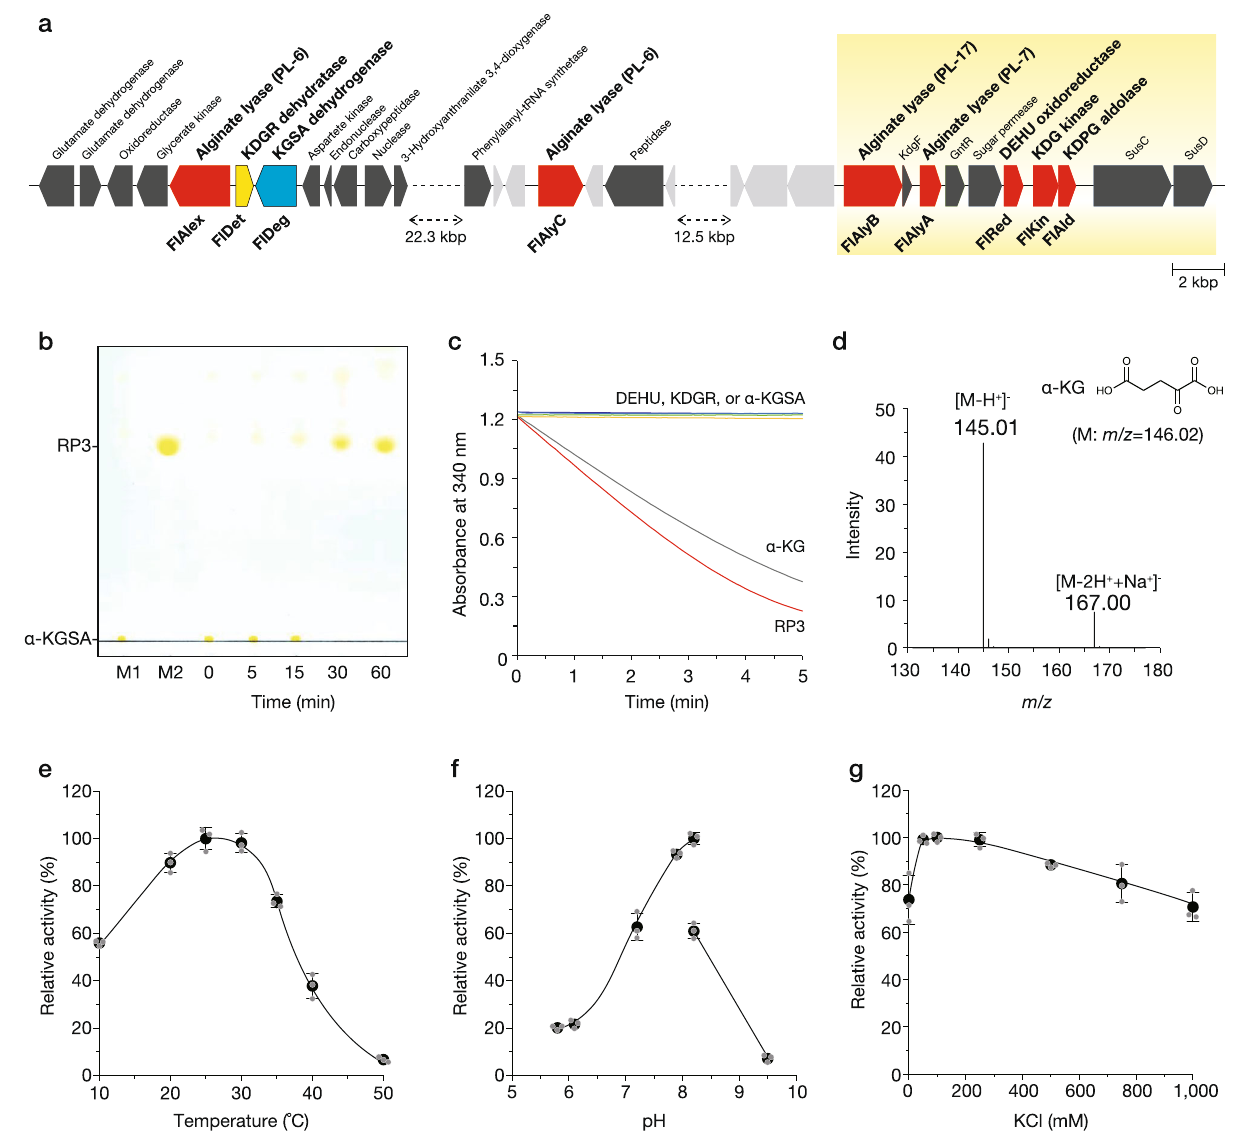
Fig. 3 Oxidation of α -KGSA by FlDeg. a The location of several genes encoding proteins for alginate metabolism in the genome of strain UMI-01. Genes shown as red pentagons encode characterized enzymes 27,33,47 . The yellow pentagon is the FlDet gene identi fi ed in this study. The blue pentagon indicated the gene for a α -KGSA dehydrogenase candidate, termed FlDeg. Dark and light gray pentagons represent genes encoding proteins, the functions of which were predicted and unpredicted from the deduced amino acid sequences, respectively. A yellow-shaded box shows the alginolytic cluster proposed in the previous studies 33, 44 . b TLC analysis of 2,4-dinitrophenylhydrazine derivatives. M1 and M2 represent the derivatives of α -KGSA (prepared from KDGR using FlDet and puri fi ed) and α -KG (commercially purchased), respectively. Reaction was conducted in a mixture containing 10 mM potassium phosphate (pH 7.4), 100 mM KCl, 1 mM MgCl 2 , 1 mM DTT, 2.5 mM NAD + , and 20 µ g mL − 1 recFlDeg at 25 °C. The enzymatic reaction was stopped by adding one- sixth volume of 6.3 mM DNP in 3 M HCl at the indicated time and the derivatization was performed as described in “ Methods ” . c Change in absorbance at 340 nm corresponding to the consumption of NADH by bovine L-glutamic dehydrogenase (GDH). Reaction was conducted in 20 mM potassium phosphate (pH 7.4), 100 mM KCl, 20 mM NH 4 Cl, 0.2 mM NADH, and 1 U mL − 1 GDH with 0.5 mM puri fi ed RP3 (red), standard α -KG (gray), DEHU (blue), KDGR (green), or α -KGSA (yellow) at 25 °C. d The negative-ion ESI mass spectrum of puri fi ed RP3. A possible structure of RP3 predicted from the determined mass is shown in the inset. e – g The effects of temperature ( e ), pH ( f ), and KCl ( g ) on recFlDeg activities. In ( e ), reaction was conducted in 10 mM potassium phosphate (pH 7.4), 100 mM KCl, 1 mM MgCl 2 , 1 mM DTT, 1 mM KDGR, and 3 µ g mL − 1 recFlDeg at the indicated temperatures for 10 min. In ( f ), the assay condition was same as that in e except that the reaction was conducted with 10 mM potassium acetate (pH 5.8 – 8.2) or 10 mM Tris-HCl (8.2 – 9.5) at 25 °C. In ( g ), the assay condition was the same as that in e except that the reaction was conducted in various concentrations of KCl at 25 °C. Relative activity at 100% was equivalent to 1.6 U mg − 1 ( e ), 2.5 U mg − 1 ( f ), and 1.6 U mg − 1 ( g ), respectively. All assays were repeated 3 times, and the data are shown as mean ± frigidarium , Z. galactanivorans, Cellulophaga baltica , and Maribacter presumed to be distributed among three classes: Polaribacter sp. 1_2014MBL_MicDiv. These bacteria belong to the same class as butkevichii and Algibacter lectus in Flavobacteriia, Sphingomonas strain UMI-01 and are likely to possess a similar dual metabolic koreensis in α -proteobacteria, and Halomonas lutea , Klebsiella system for DEHU. In addition, this dual metabolic system was pneumoniae , and Pseudoalteromonas atlantica in γ -proteobacteria.